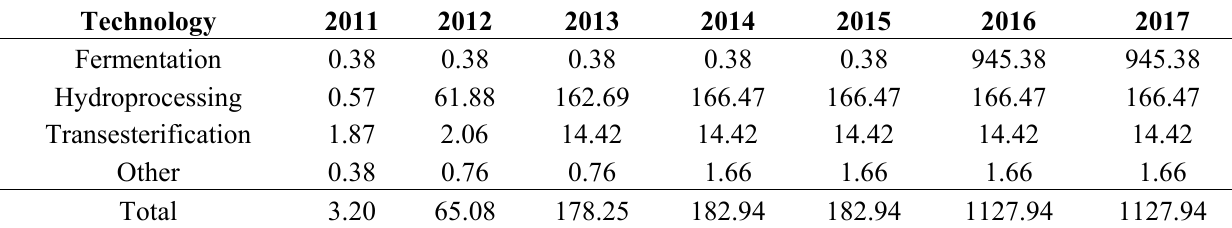
Table 3. Projected algae biofuel capacity worldwide (million L) [39].